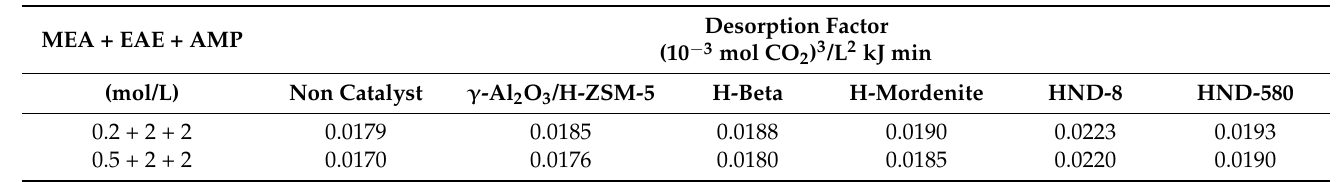
Table 3. The desorption factors of tri-solvent of MEA+EAE+AMP solvents at 0.2 + 2 + 2 and 0.5 + 2 + 2 mol/L with 5 g solid acid catalysts at 30 min.